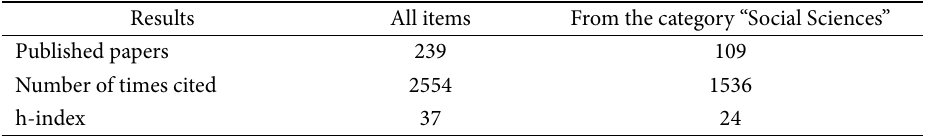
Table 1. Published and cited papers in ISI Web of Science database Results All items From the category “Social